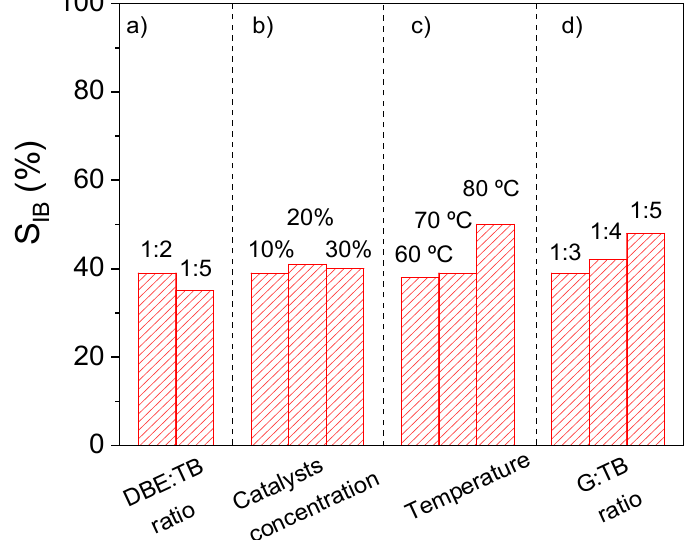
Figure 4. Effect of different operating variables on IB selectivity. Operating conditions: 70 °C, G:TB = 1:3, C cat = 20% ( a ), 70 °C, G:TB = 1:3, DBE:TB = 1:2 ( b ), G:TB = 1:3, DBE:TB = 1:2, Ccat = 20% ( c ) 70 °C, DBE:TB = 1:2, C cat = 20% (d).